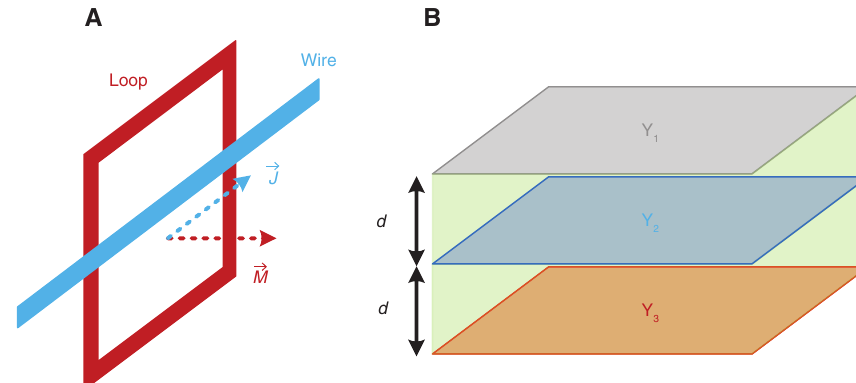
Figure 3: Two different realizations of Huygens’ unit cells. (A) Wire/loop unit cell. (B) Stacked three-layer shunt-admittance unit cell.